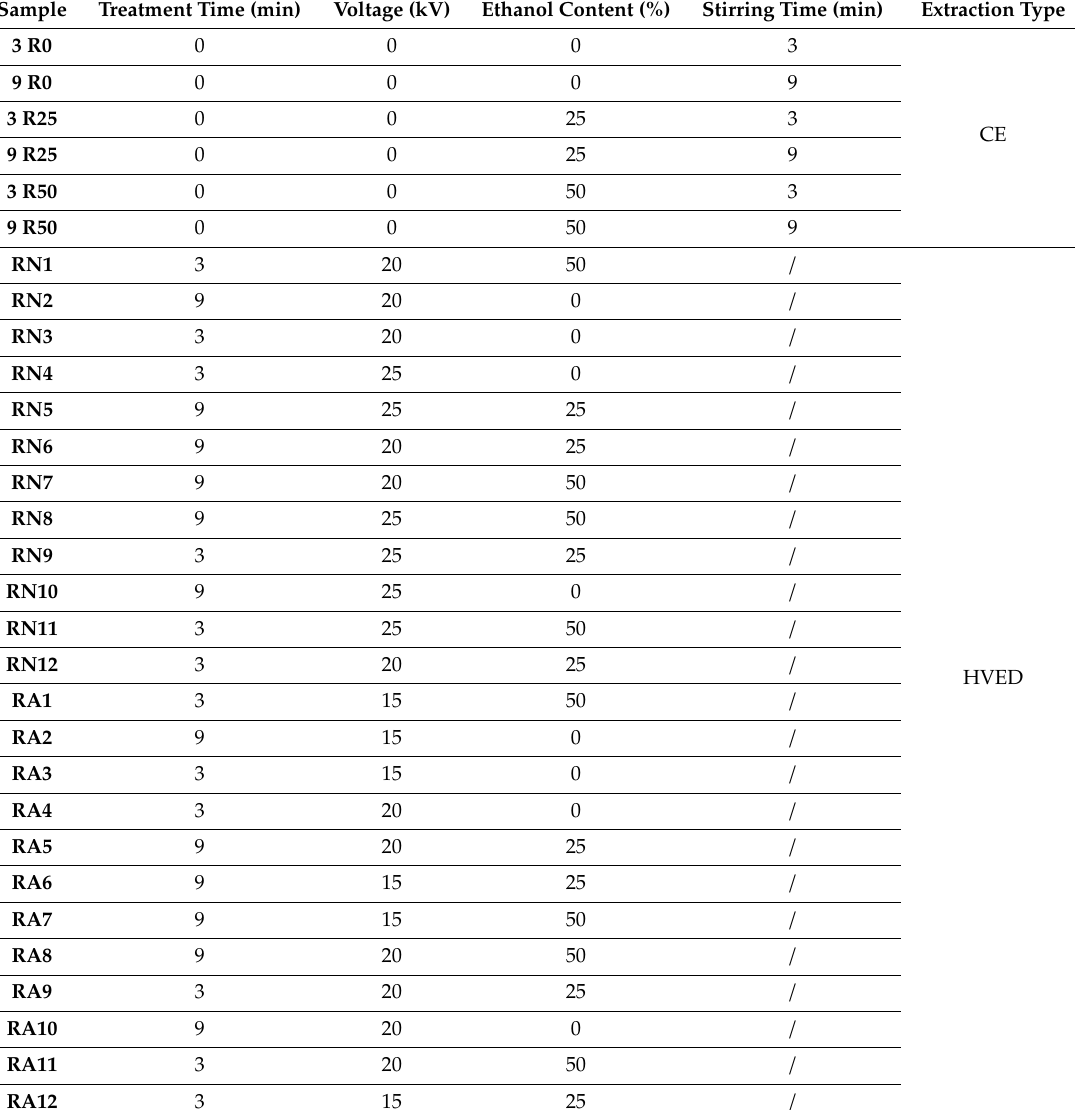
Table 3. Denotation of samples, experimental design, and process